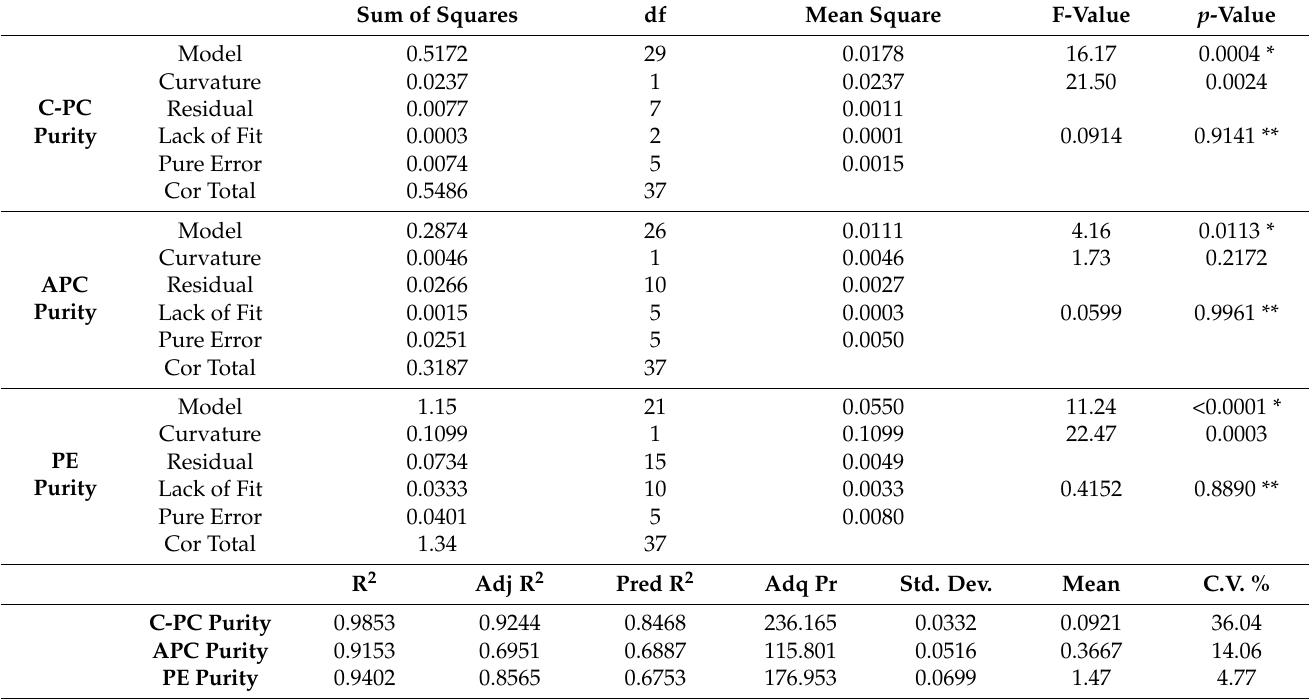
Table 3. Analysis of variance (ANOVA) of the model obtained for phycobiliprotein purity. Sum of Squares df Mean Square F-Value p